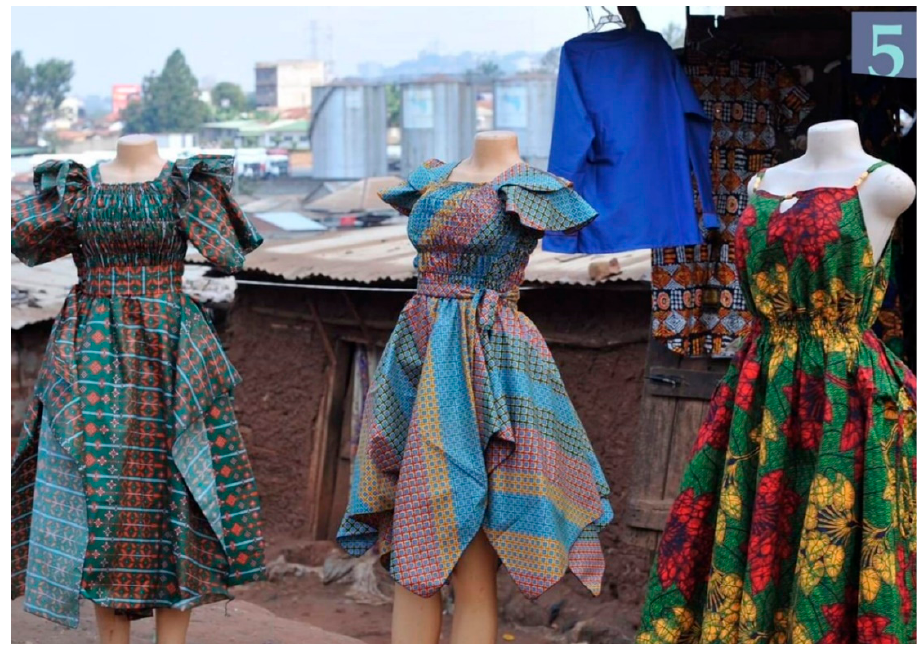
Figure 5. 3 African Print Dresses (photo number 15).